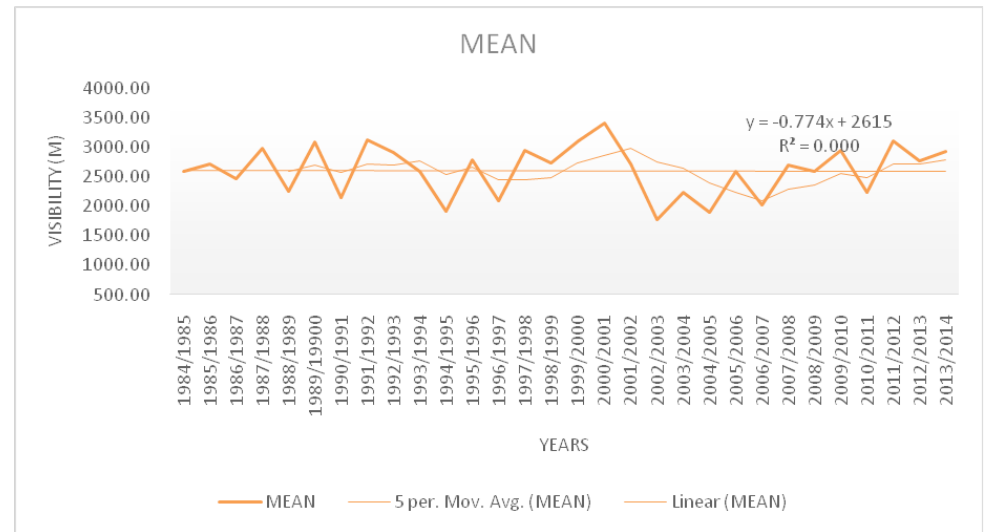
Figure 4: Seasonal mean distribution and trend of air visibility for Gombe station (1984-2014).